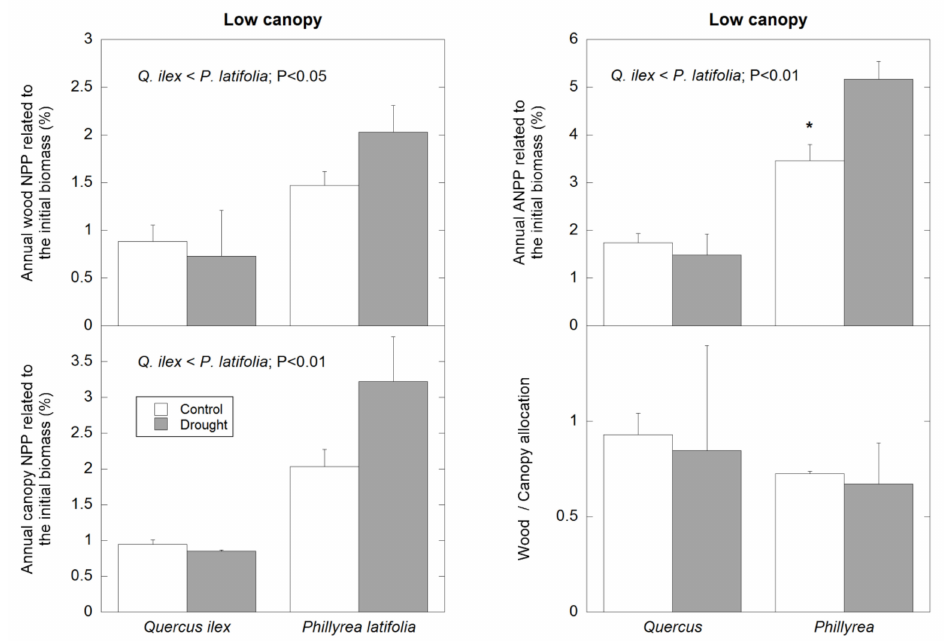
Figure 5. Average percentage of wood NPP, canopy NPP, ANPP, and wood / canopy allocation of the two dominant species, in control and plots with partial rainfall exclusion (drought plots), located in the low canopy stand. Depicted data correspond to the NPP during the overall studied period (1999–2019). *: